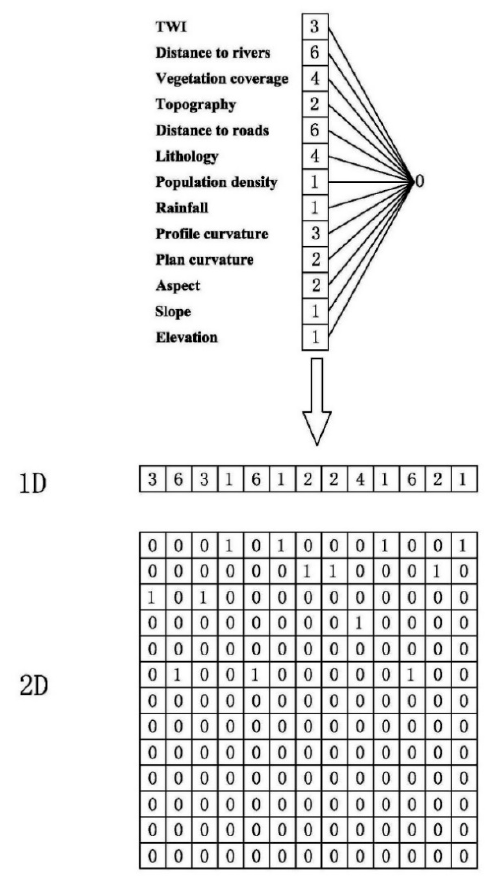
Figure 4. One–dimensional to two–dimensional schematic. Table 2. Database for influencing